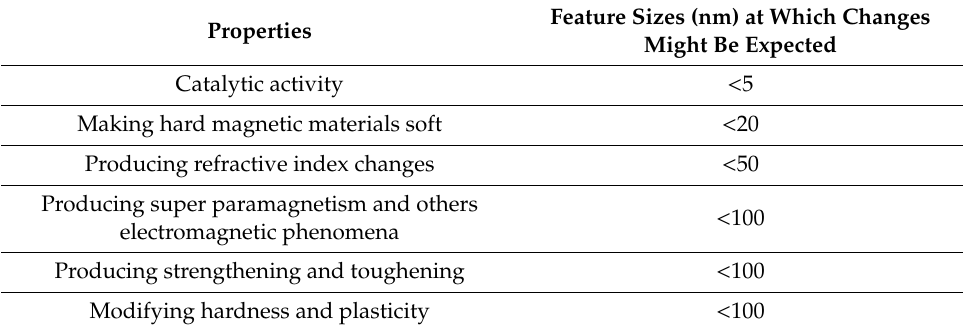
Table 1. E ff ect of nanoparticle size on matrix properties [5] (http: // creativecommons.org / licenses / by / 4.0 /